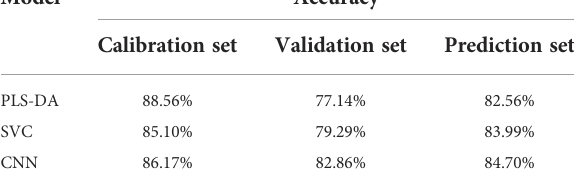
TABLE 4 The results of the classi fi cation models based on full spectra.